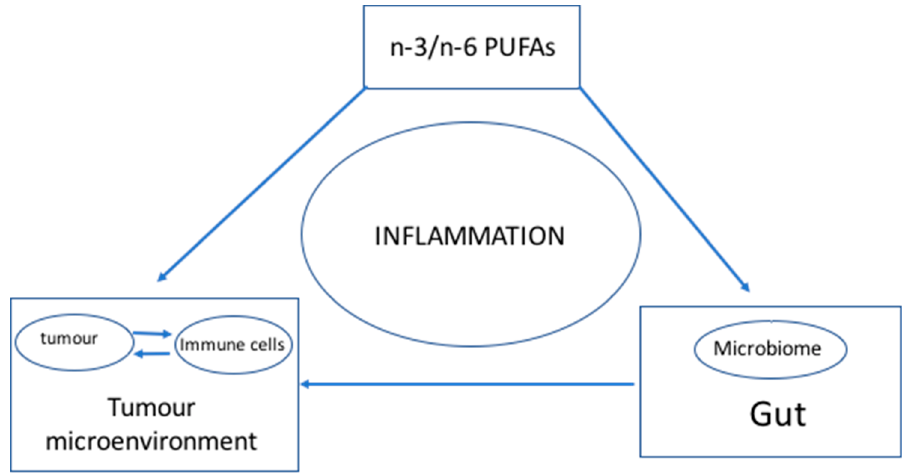
Figure 1. The hypothesis. Inflammation is the central element in the relationship among LC-PUFAs, the gut microbiome and the tumour microenvironment/immune system. Inflammation is regulated by the interaction of the components of the triad. LC-PUFAs (n-3 and n-6 fatty acids) have been shown to directly regulate cancer cells and immune cells as well as modulating the inflammatory state that sustains the tumour microenvironment which promotes the growth and malignancy of tumours. Simultaneously, LC-PUFAs have a direct role on microbial growth in the gut, which has consequences to the inflammatory state of the gut. Gut dysbiosis has a direct consequence in promoting inflammation in the tumour microenvironment suppressing the anti-tumour activities of the immune cells and immune checkpoint inhibitors. The model supports the role of LC-PUFAs in regulating the progression of cancer directly and indirectly through the gut microbiome assisting in modifying the tumour microenvironment.